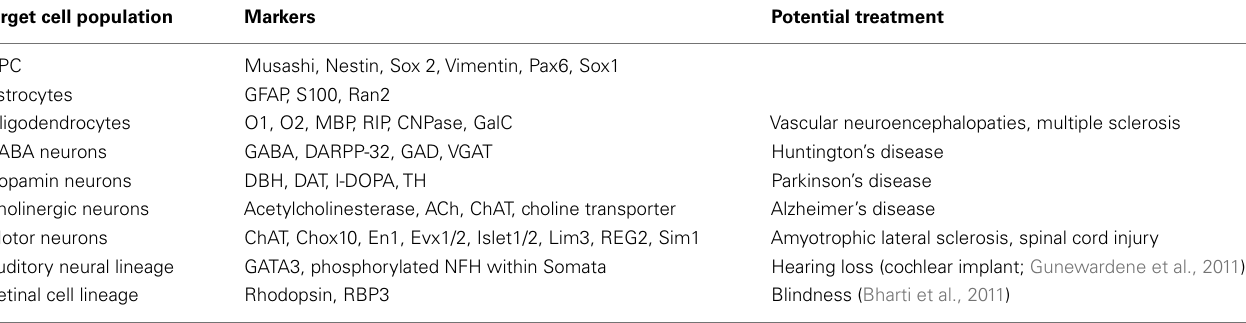
Table 3 |A specific cell type for a specific